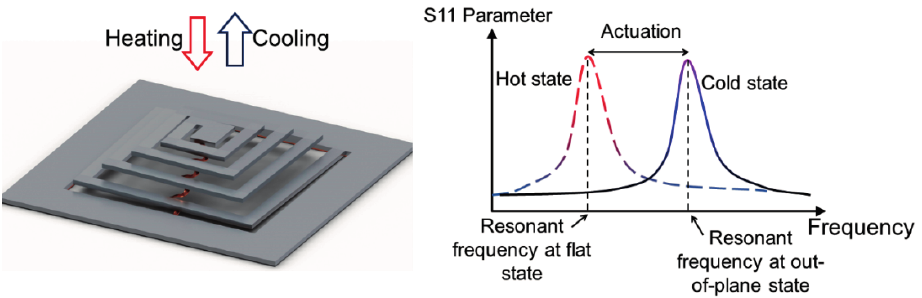
Figure 1. Wireless radiofrequency (RF) control and sensing of the shape-memory-alloy (SMA) spiral-coil actuator: Conceptual diagram and working principle of the